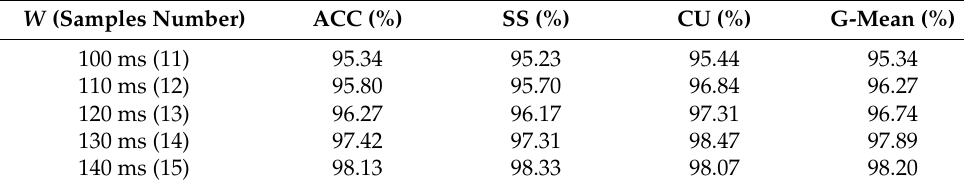
Table 8. Metrics comparison among different time-window